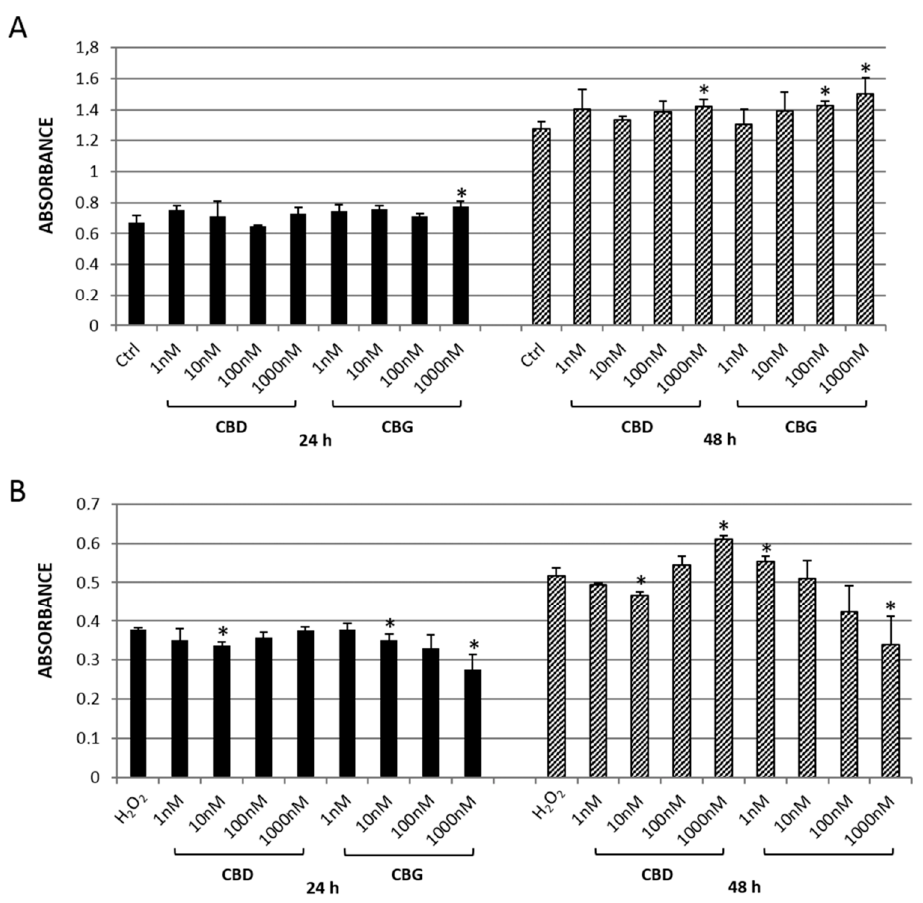
Figure 1. MTT assay of CTX-TNA2 astrocyte cell line exposed to di ff erent concentrations (1–1000 nM) of either cannabidiol (CBD) or cannabigerol (CBG) for 24 (black bars) and 48 h (grey bars). ( A ) Cells in basal conditions. ( B ) Cells challenged with 300 µ M H 2 O 2 . The data graph bars are the mean ± SD ( n = 3). ANOVA, * p < 0.05 vs. control group.